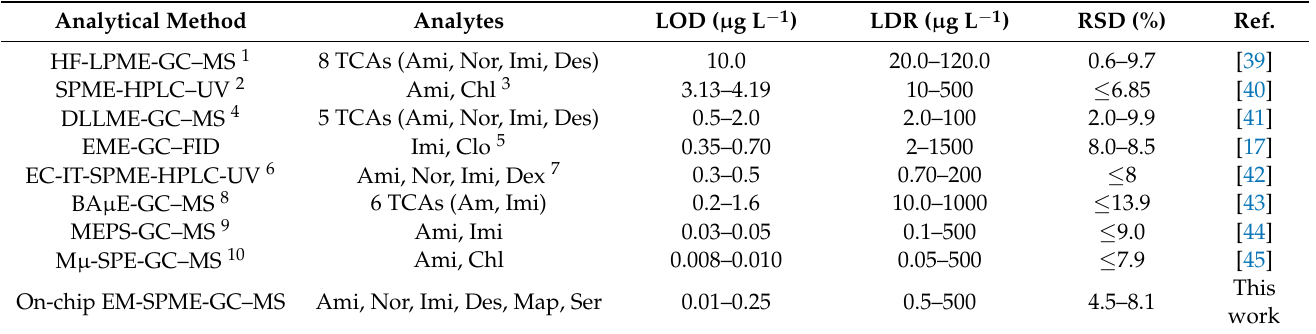
Table 2. Comparison of the proposed method with other relevant methods for determination of